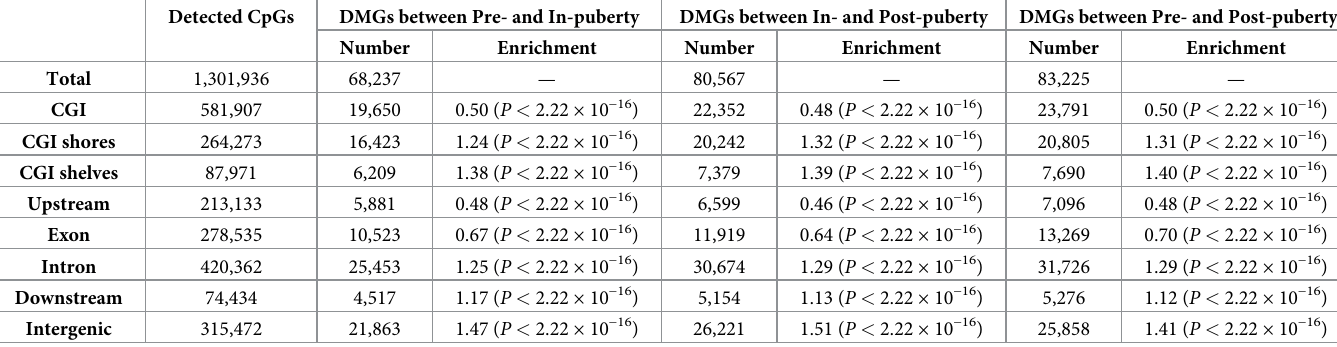
methylation profiles were profiled for the pituitary tissues of Pre-, In- and Post-pubertal gilts. Table 1. Distribution of differentially methylated CpGs among these